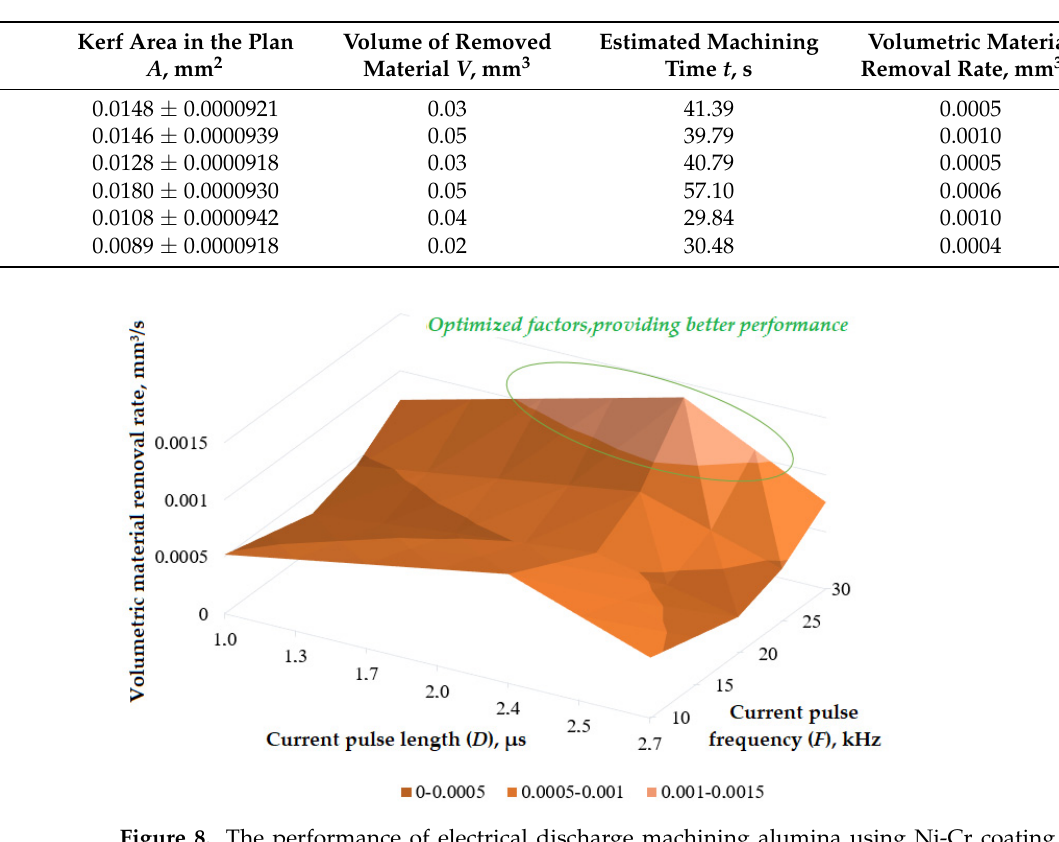
Table 12. The material removal rate of electrical discharge machining alumina ceramics using a 12 µm thick Ni-Cr coating and SnO-suspension (150 g/L).